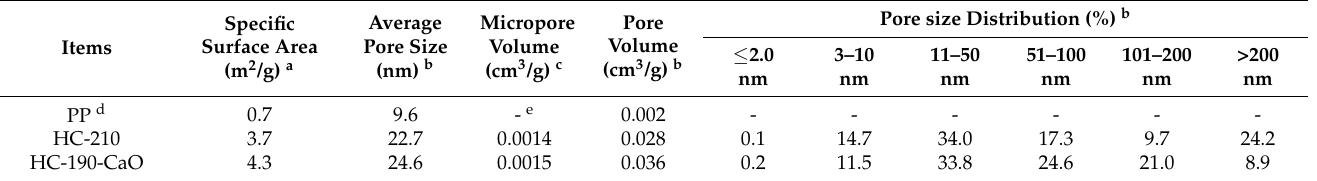
Table 3. Specific surface area, pore size, and pore volume of raw PP and HC